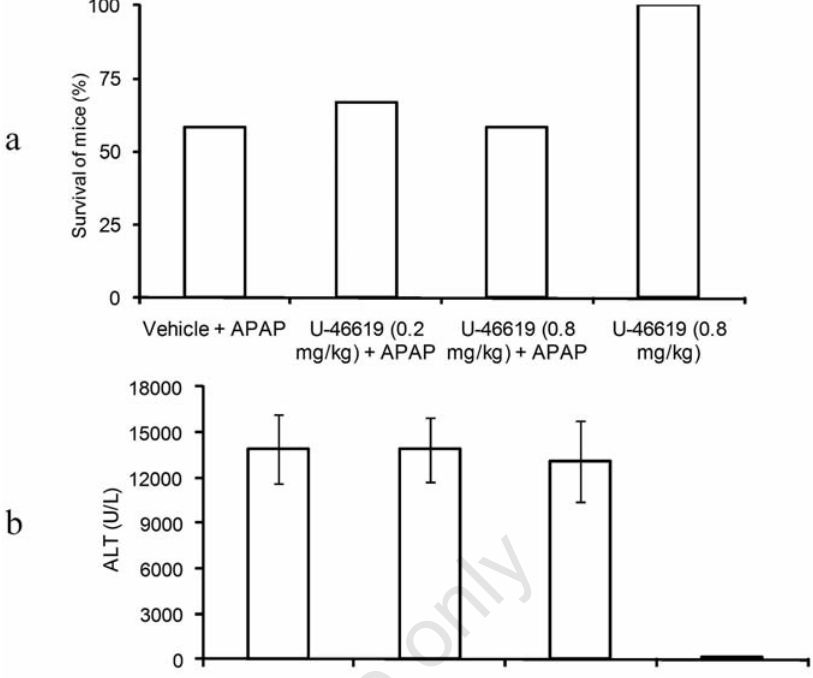
Figure 3. Effect of U-46619 on survival and plasma ALT concentration in mice with APAP-induced liver injury. (A) APAP (250 mg/kg) was given by oral gavage and survival was recorded 48 h later. U-46619 (0.2 and 0.8 mg/kg, i.v.) and vehicle were given 30 min before APAP administration. N=12 mice per group. p>0.05 in comparison to vehicle group. (B) To determine the plasma ALT concentration, mice were treated as in the previ- ous experiment, except that mice received a lower dose of APAP (150 mg/kg). Results rep- resent mean±SEM of 8 mice per group. The level of ALT in mice which received U-46619 alone was as in the normal mice and significantly decreased in comparison to other groups of animals (P<0.001). P>0.05 for all other comparisons.